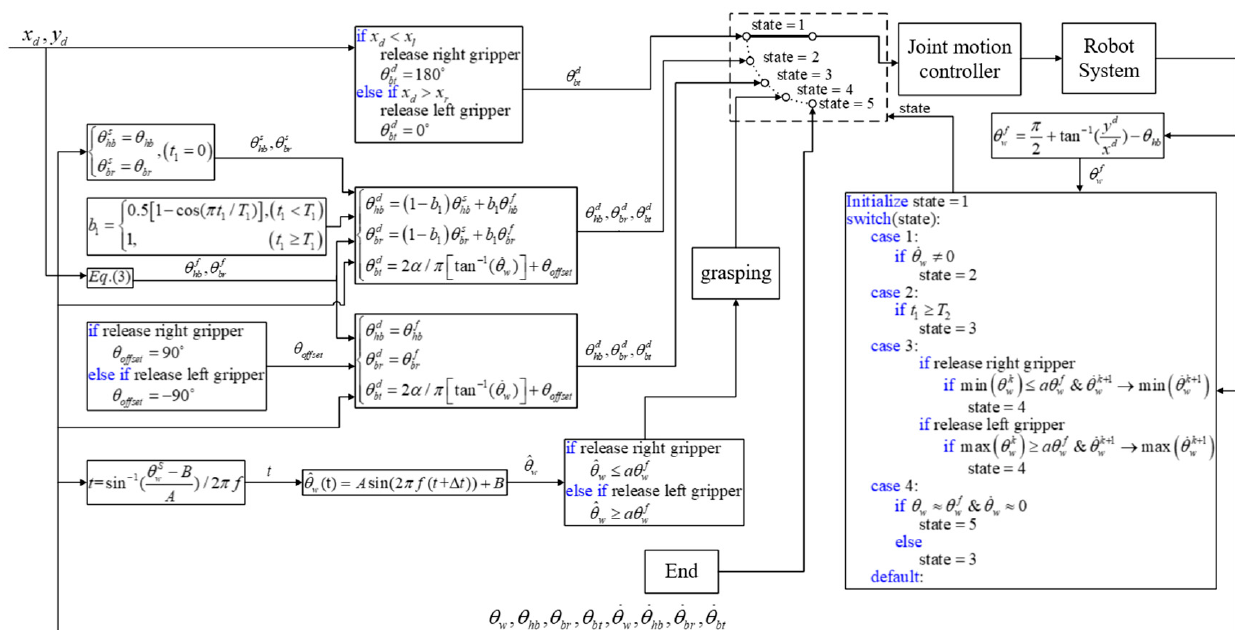
Figure 12. Block diagram showing the proposed locomotion control strategy for transverse ledge brachiation.